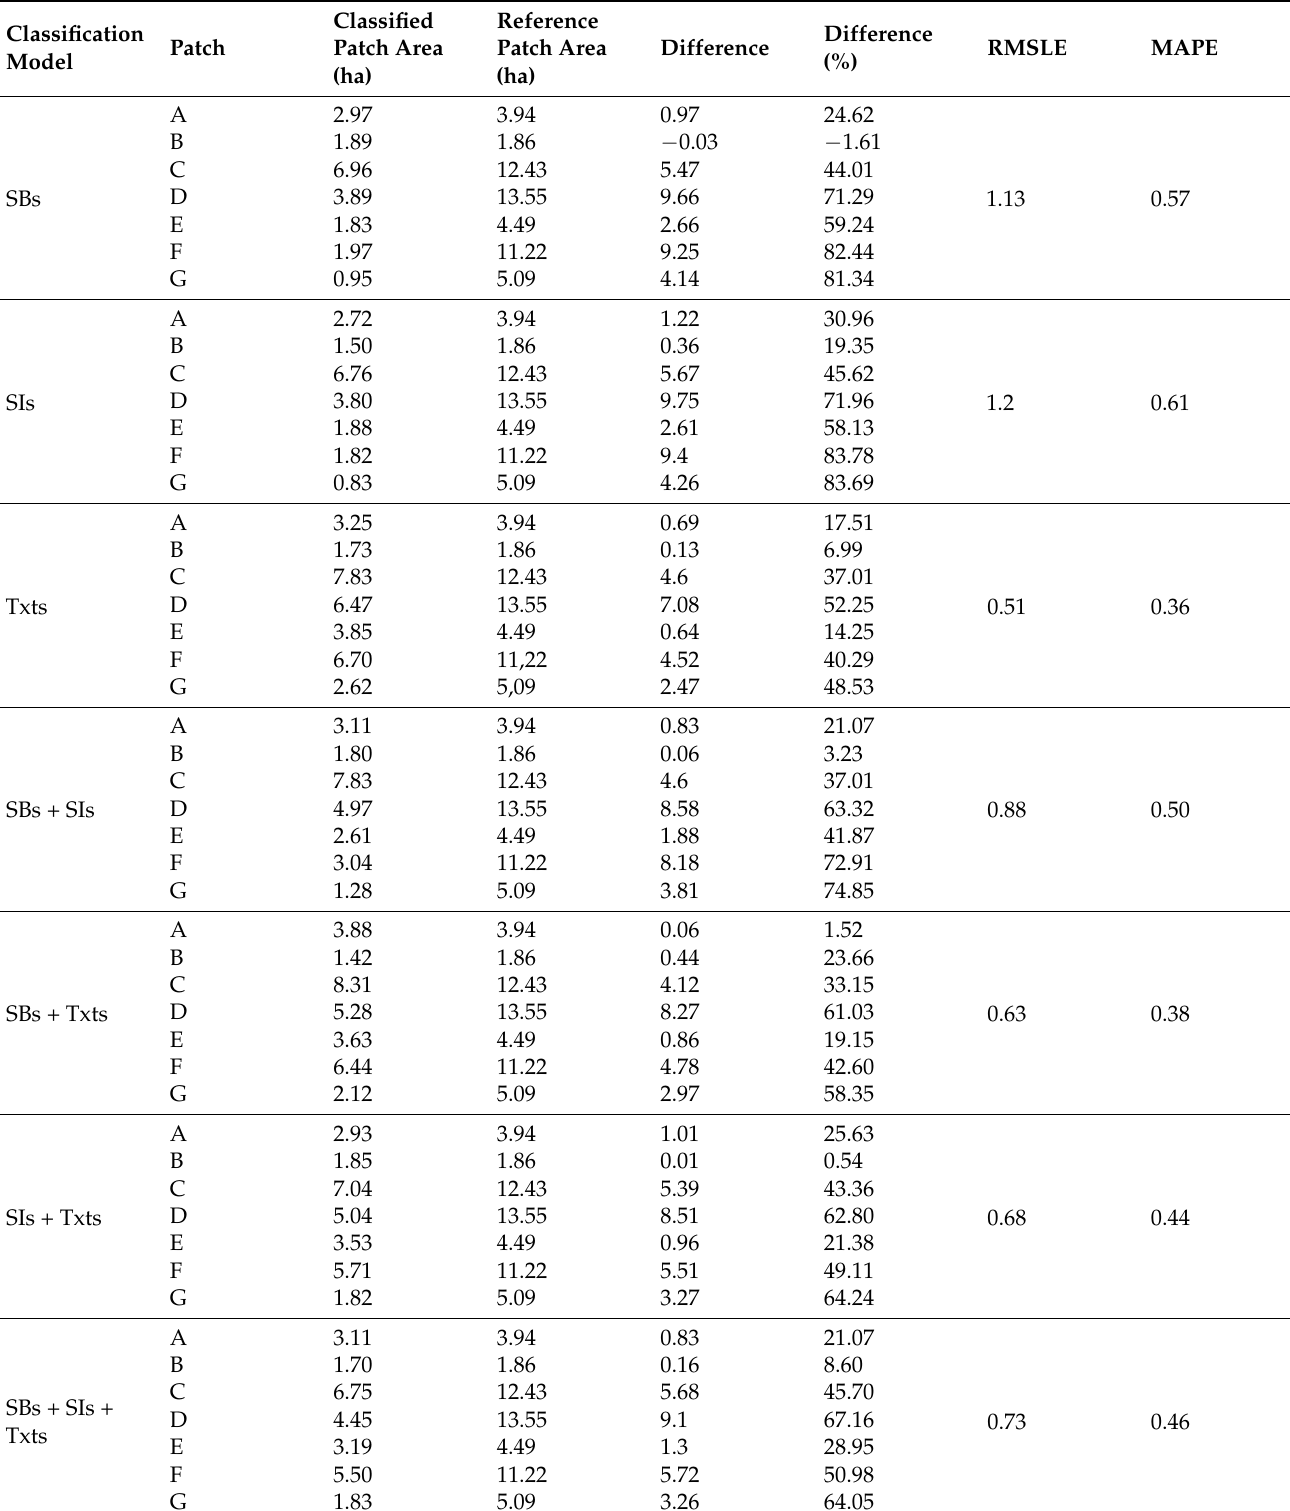
Table 6. Spatial accuracy assessment results for area-based